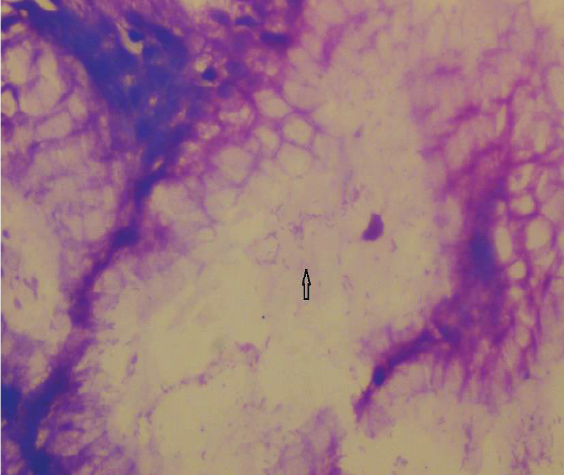
Fig-7: H.p ylori in gastric pits on Modified McMullen’s Stain 40x